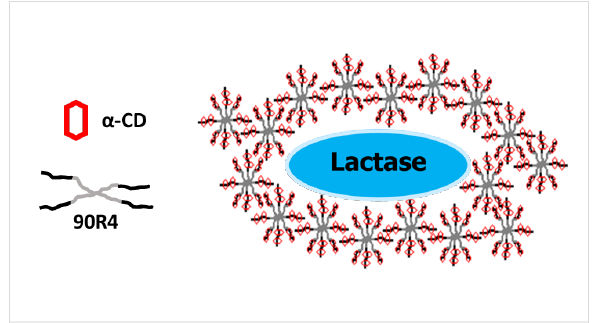
Figure 2: 90R4/ α -CD gels loaded with lactase. Octablock Tetronic molecules (grey) are threaded by CDs (red) forming a supramolecular assembly that entraps the protein molecules (blue).